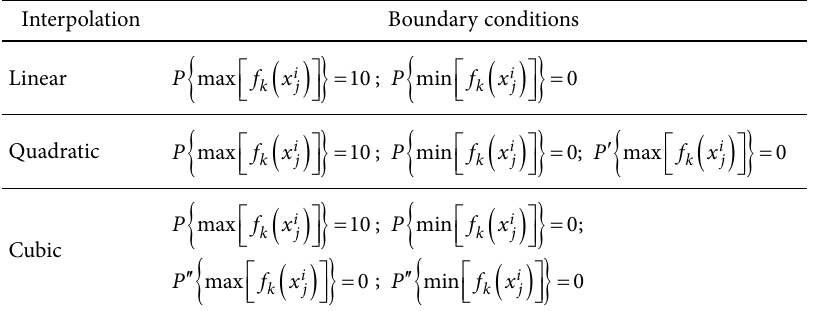
Table 2. Spline interpolation boundary